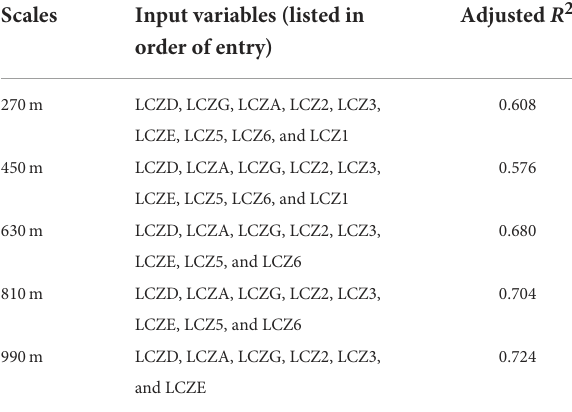
TABLE 4 Adjusted R 2 of stepwise regression